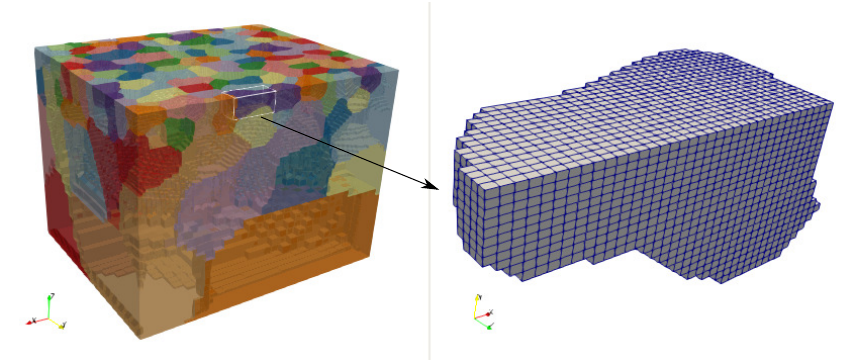
Figure 2. Example of the mesh partitioning performed by means of METIS